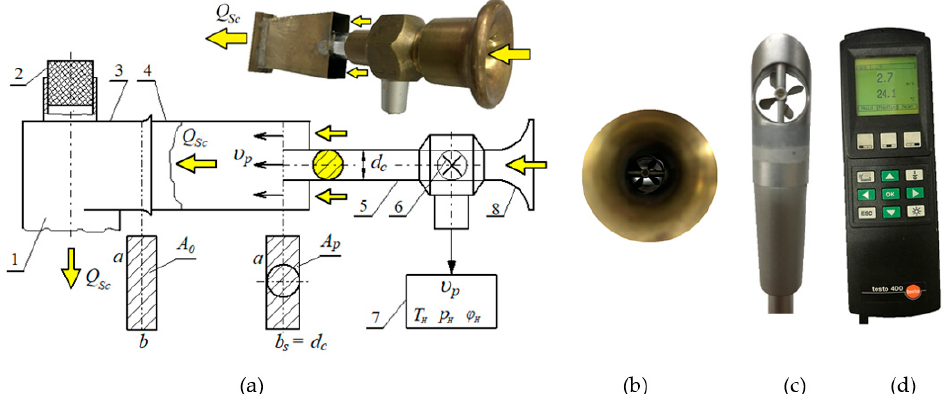
Figure 23. The system for measurement of the sucked flows Q Sc from the individual cyclones of the MT multicyclone: ( a ) functional diagram (1—cylindrical part of cyclone body, 2—plug closing cyclone outlet pipe, 3—cyclone inlet stub-pipe, 4—connecting duct, 5—measuring duct, 6—vane probe, 7—readout panel of velocity value, 8—inlet lemniscate), ( b ) view of vane probe in measuring duct, ( c ) vane probe, and ( d ) reading panel of measured parameters.